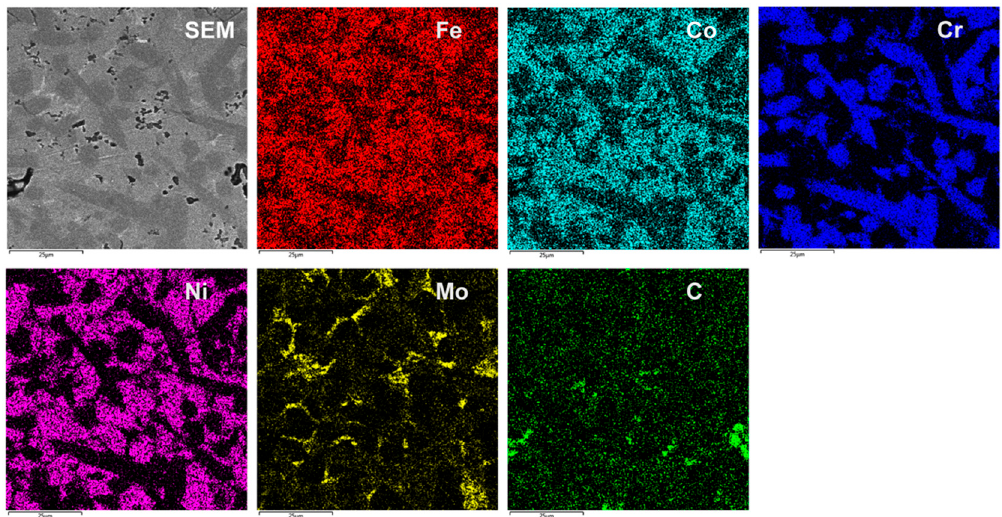
Figure 4. SEM image and EDX maps of Fe, Co, Cr, Ni, Mo, and C of marked area in Figure 3a of HEA after spark plasma sintering (SPS) at 1150 °C and 30 MPa.